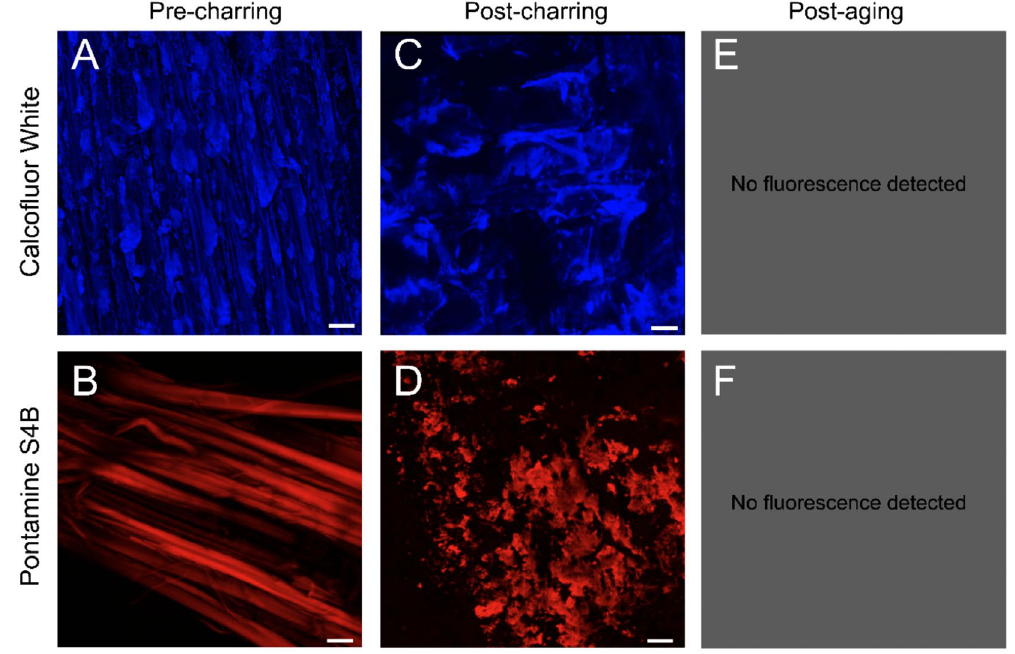
Figure 3. β -1,4-glucans and crystalline cellulose are disrupted by charring and are eliminated after aging from the C Layer. Confocal microscopy images of the C layer stained with Calcofluor White to show β -1,4-glucans ( A , C , E ) and Pontamine S4B to show crystalline cellulose ( B , D , F ). Panels A and B show the presence of β -1,4-glucans and crystalline cellulose in the C layer before the stave has been charred. Panels C and D show that disruption of β -1,4-glucans and crystalline cellulose occurred during charring. In panels E and F, no fluorescence was detected, indicating a loss of β -1,4-glucans and crystalline cellulose from the C layer following